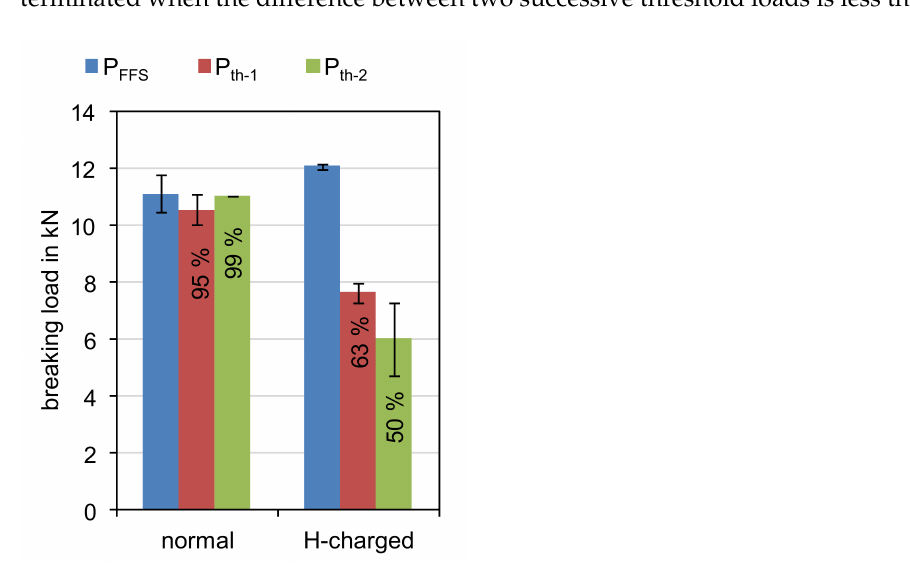
images of a specimen charged with hydrogen. In the overview, a different fracture structure between the edge and the core region can be seen in the two states. The core region